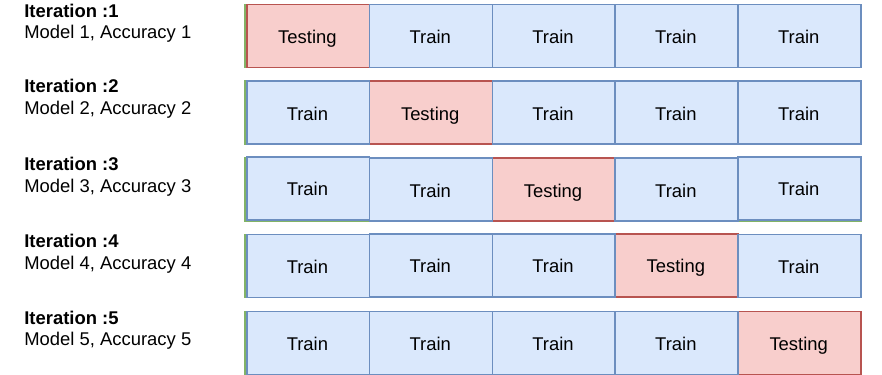
Figure 1. Five‑fold cross‑validation for stacking sentiment classifier.